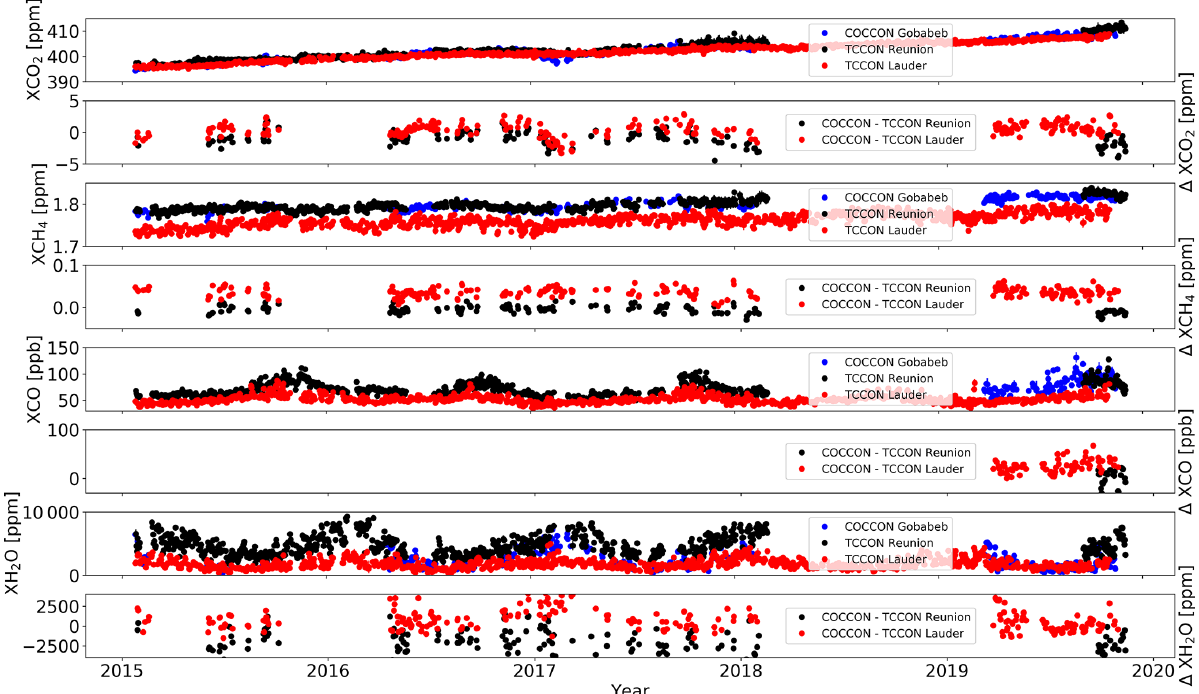
Figure 6. Column-averaged dry-air mole fraction daily mean time series for XCO 2 , XCH 4 , XCO and XH 2 O measured at the COCCON site in Gobabeb, Namibia (blue dots), and at the TCCON sites Réunion Island (black dots) and Lauder (red dots). Error bars denote the 1 σ standard deviation of the daily mean values. Additionally, the difference XCO 2 , XCH 4 , XCO and XH 2 O time series between Gobabeb and Réunion Island (black dots) and between Gobabeb and Lauder (red dots) are shown in separate panels.